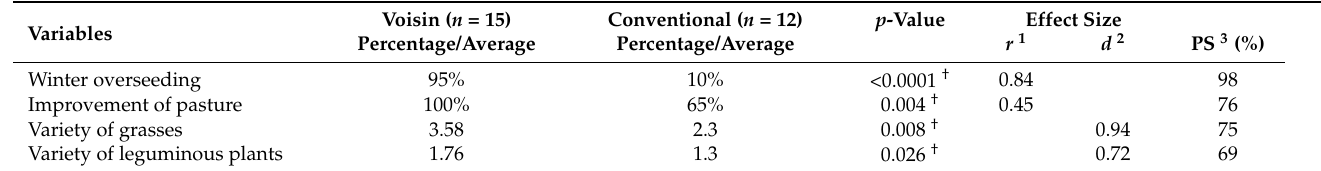
Table 2. Percentage of farmers that use pasture improvement techniques and a variety of grasses and leguminous plants in the pasture area.